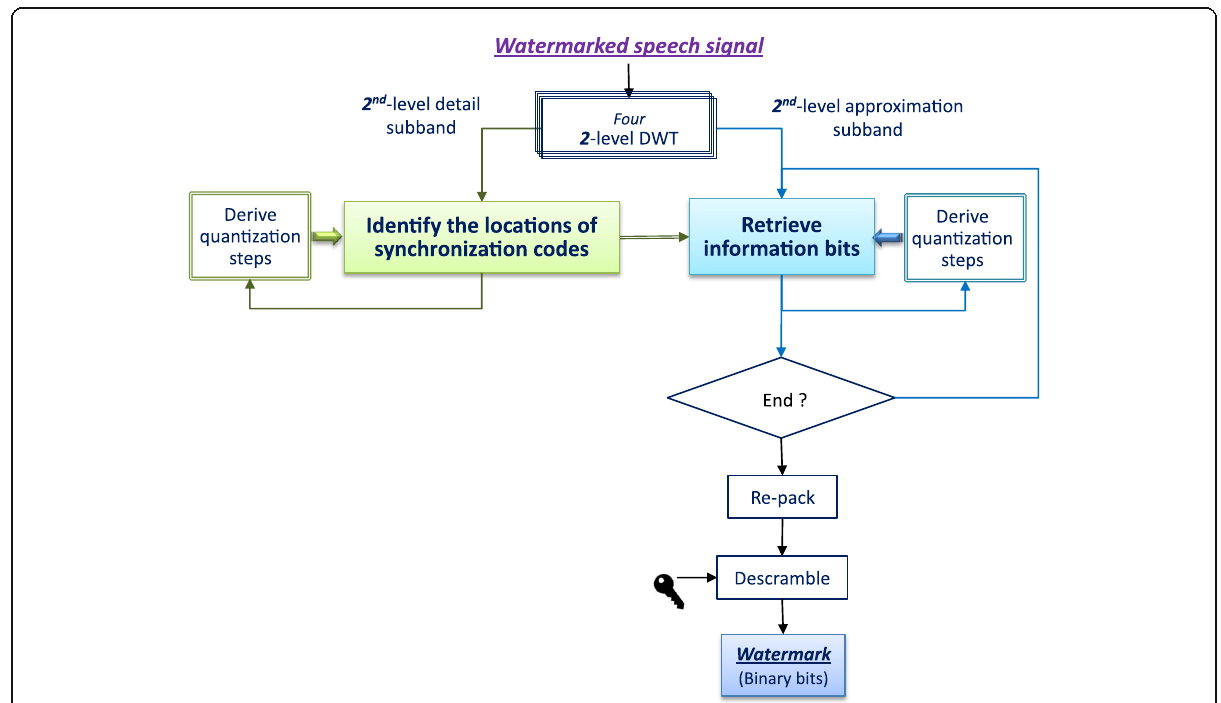
Fig. 5 Extraction procedure of the proposed DWT-AMM watermarking